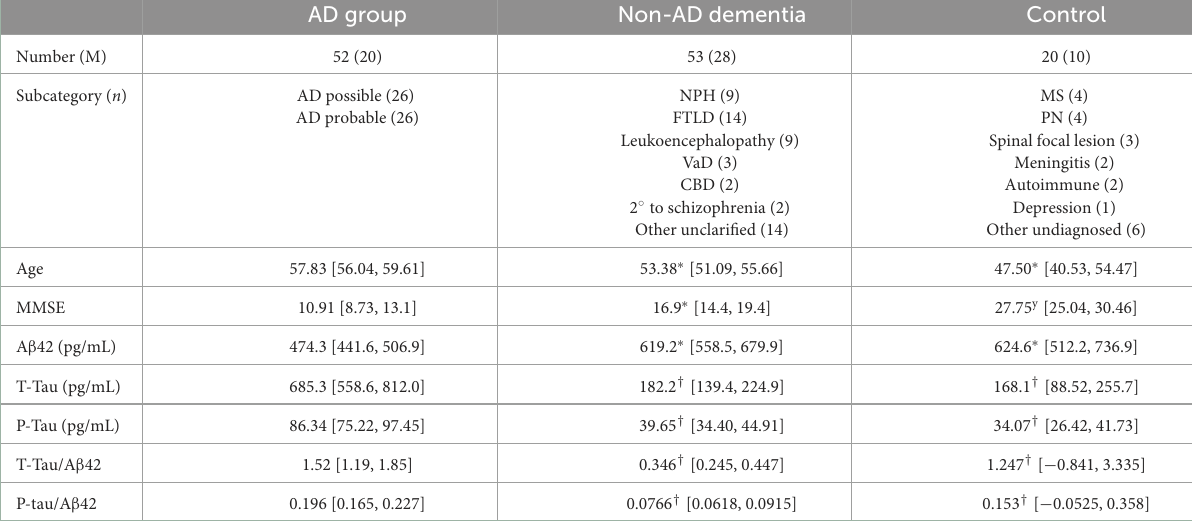
TABLE 1 Demographic data and biomarker